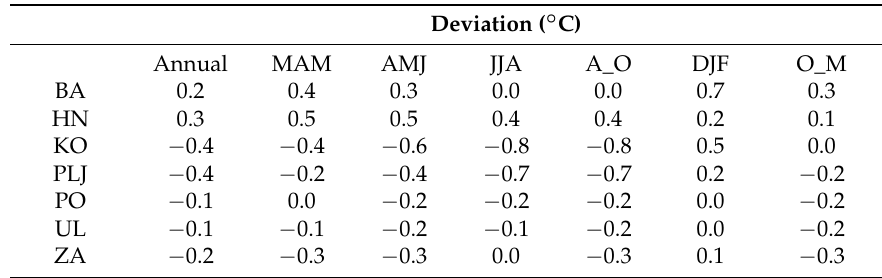
Figure 3. The deviation of the normal monthly temperature for current (1981–2010) and future (2001–2030, 2071–2100) climate in respect to past climate conditions (1971–2000). The deviation for 1981–2010 is shown in blue; for 2001–2030 in orange; and for 2071–2100 in gray. Table 5. The deviation of the normal temperature for 2001–2030 with respect to the referent climatology of 1981–2010.